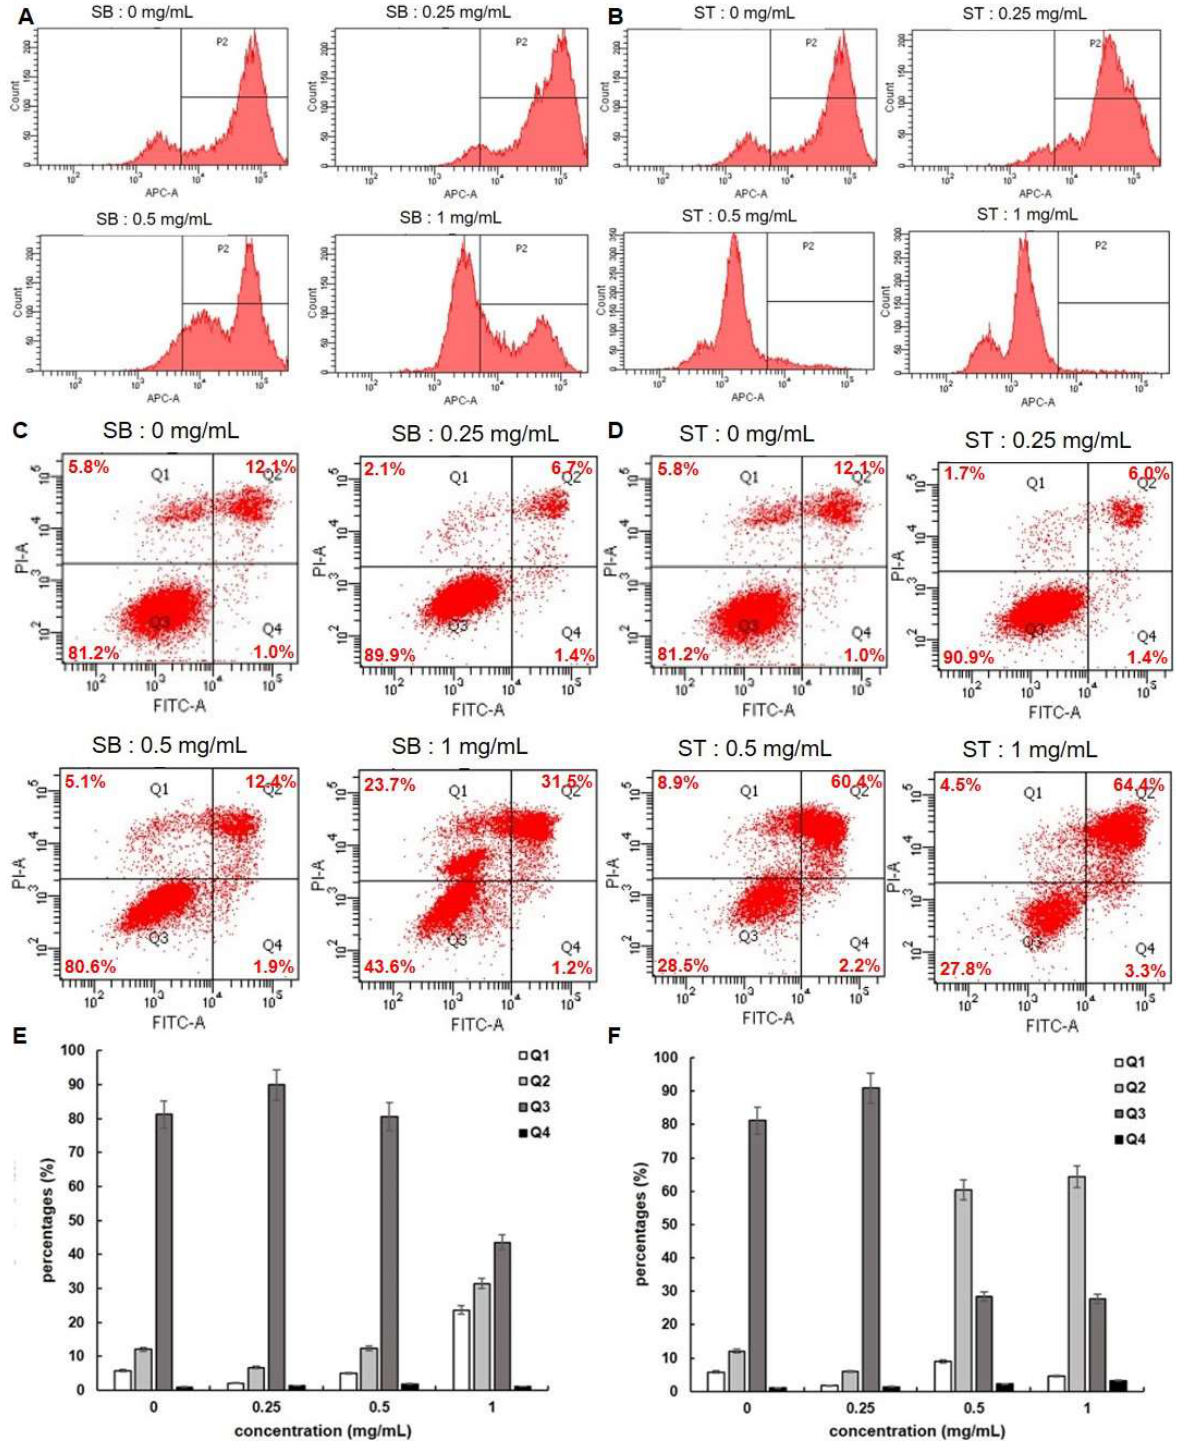
Figure 5. Apoptosis assessment of HSC-3 cells treated with indicated concentrations of SB and ST. ( A , B ) Detecting mitochondrial depolarization with Mitostatus reagents. ( C , D ) Flow cytometric analysis of PS externalization (annexin V binding) and cell membrane integrity (PI staining). Cells were treated with 0, 0.25, 0.5 and 1 mg/mL of SB and ST for 72 h. The dual parameter dot plots combining annexin V-FITC and PI fluorescence show the vial cell population in the lower left quadrant (Q3), the early apoptotic cells in the lower right quadrant (Q4), the late apoptotic cells in the upper right quadrant (Q2), and the necrosis cells in the upper left quadrant (Q1). ( E , F ) Percentages of Q1, Q2, Q3 and Q4 cells. Bars represent standard deviations from triplicate determinations.